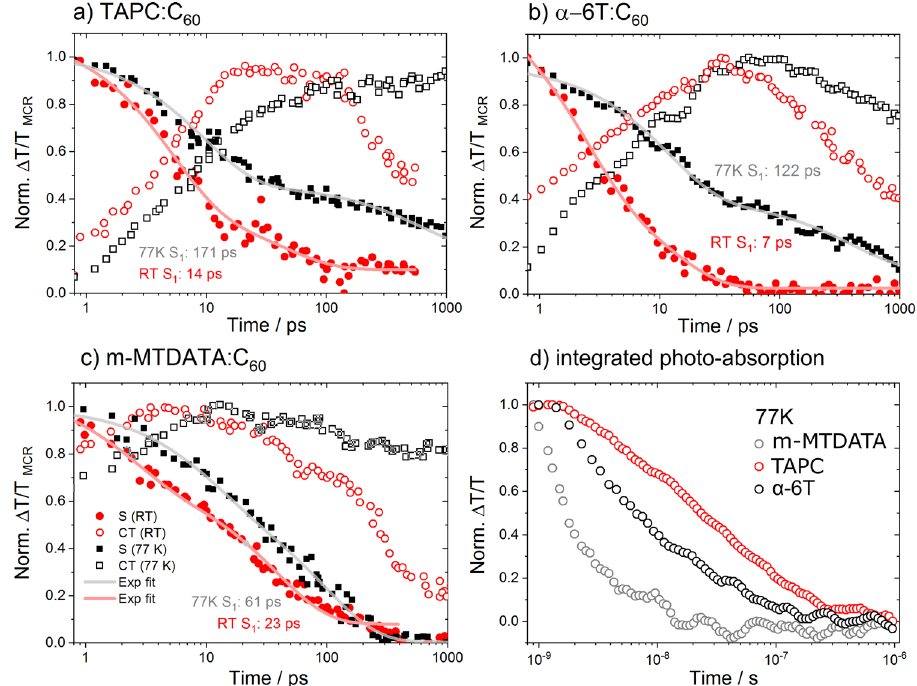
Fig. 5 Transient absorption kinetics of dilute blends at ambient and cryogenic temperatures. a – c Picosecond – nanosecond TA kinetics extracted from MCR analysis of TA spectra of dilute blends at room temperature (RT) and 77 K. Closed symbols: singlet state dynamics (labeled S), open symbols: charge + CT dynamics (labeled CT). Black squares: 77 K, red circles: RT. Comparison to raw spectra and signatures extracted from MCR are shown Supplementary Fig. 11. d Integrated remaining photo-induced absorption in the 1.8 – 2 eV region at long time delays (ns – µ s) for dilute blends with various donors at 77 K (300 K in Supplementary Fig. 9). The excitation wavelength for both ps-ns and ns – µ s TA is 532 nm. The solid lines are bi-exponential fi ts to the decay (time constants AEAE pattern, the fi eld position and the time decay are features commonly observed in TREPR spectra of long-living CT states 59 .